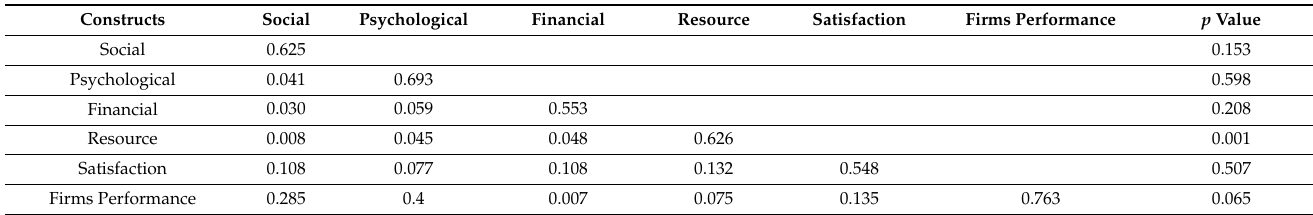
Table 5. Discriminant validity and correlation analysis.